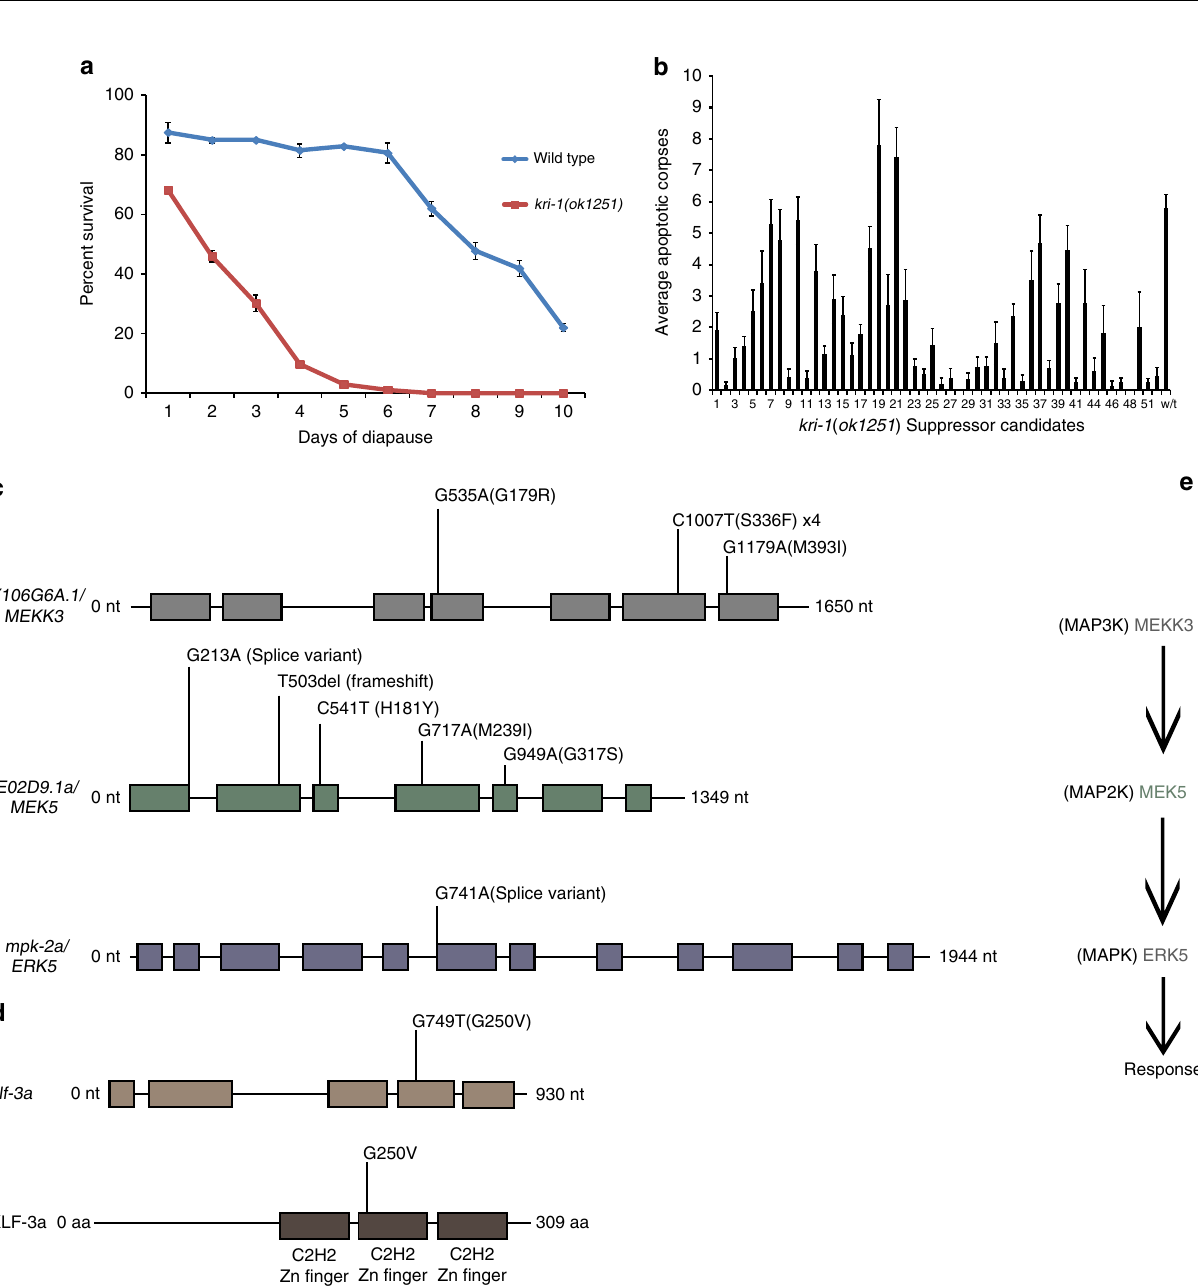
Fig. 2 A kri-1 suppressor screen identi fi es the ERK-5/MAPK pathway and KLF-3. a Survival of wild type and kri-1(ok1251) L1 larvae in liquid buffer (M9) without food ( n ≥ 600). b IR-induced germline apoptosis in the progeny of kri-1(ok1251) suppressor candidates that survived 7 days of starvation (52 of 300 candidates depicted, n ≥ 15). The black bar is the mean ± standard deviation. c Twelve of the 13 kri-1(ok1251) suppressor candidates have recessive mutations in ERK-5/MAPK pathway genes. d The 13th kri-1(ok1251) suppressor candidate has a dominant mutation in the KLF transcription factor gene